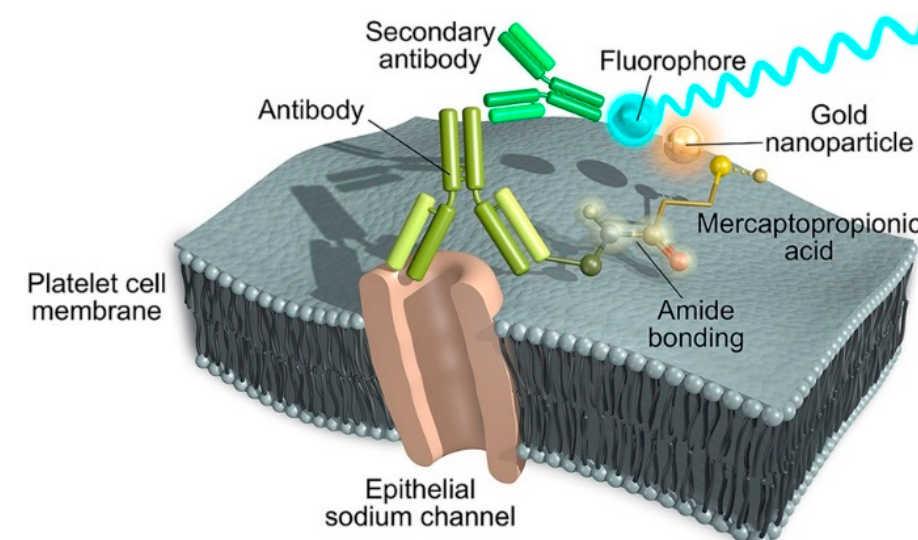
Figure 15. Optical immunosensor for epithelial sodium channel in blood. Fluorescein-tagged sec- ondary antibodies are directed to epithelial sodium channel which is captured using colloidal AuNPs-antibodies conjugates. When the analyte is detected, the fluorescent antibodies are revealed and the signal is enhanced by taking advantage of the AuNPs-induced plasmonic effect. Image adapted from [107] with permission of Elsevier, 2020.